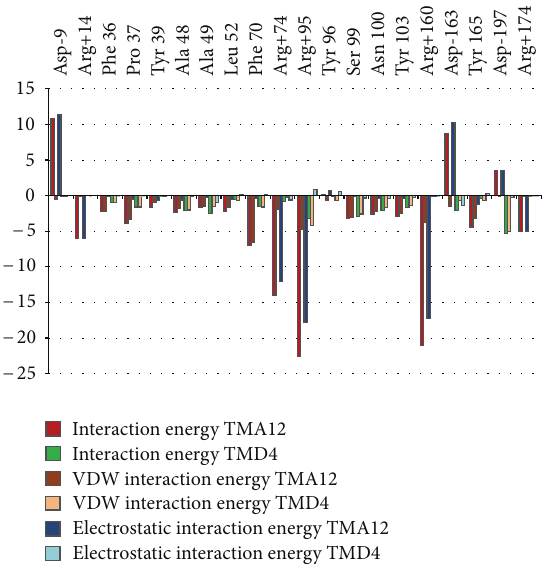
Figure 4: Interaction Energy breakdown comparison for the most active training set compound TMD4 and for the most active designed